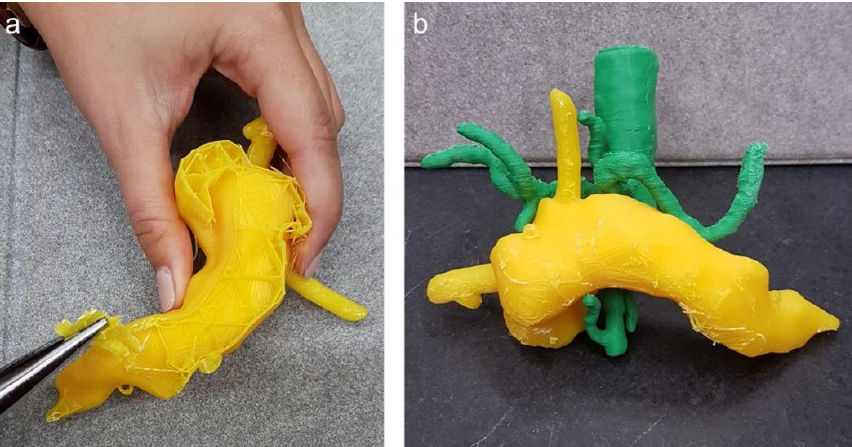
Figure 7. ( a ) Post-processing of the 3D pancreas replica with splint; ( b ) pancreas with aorta, coeliac truncus and superior mesenteric artery.